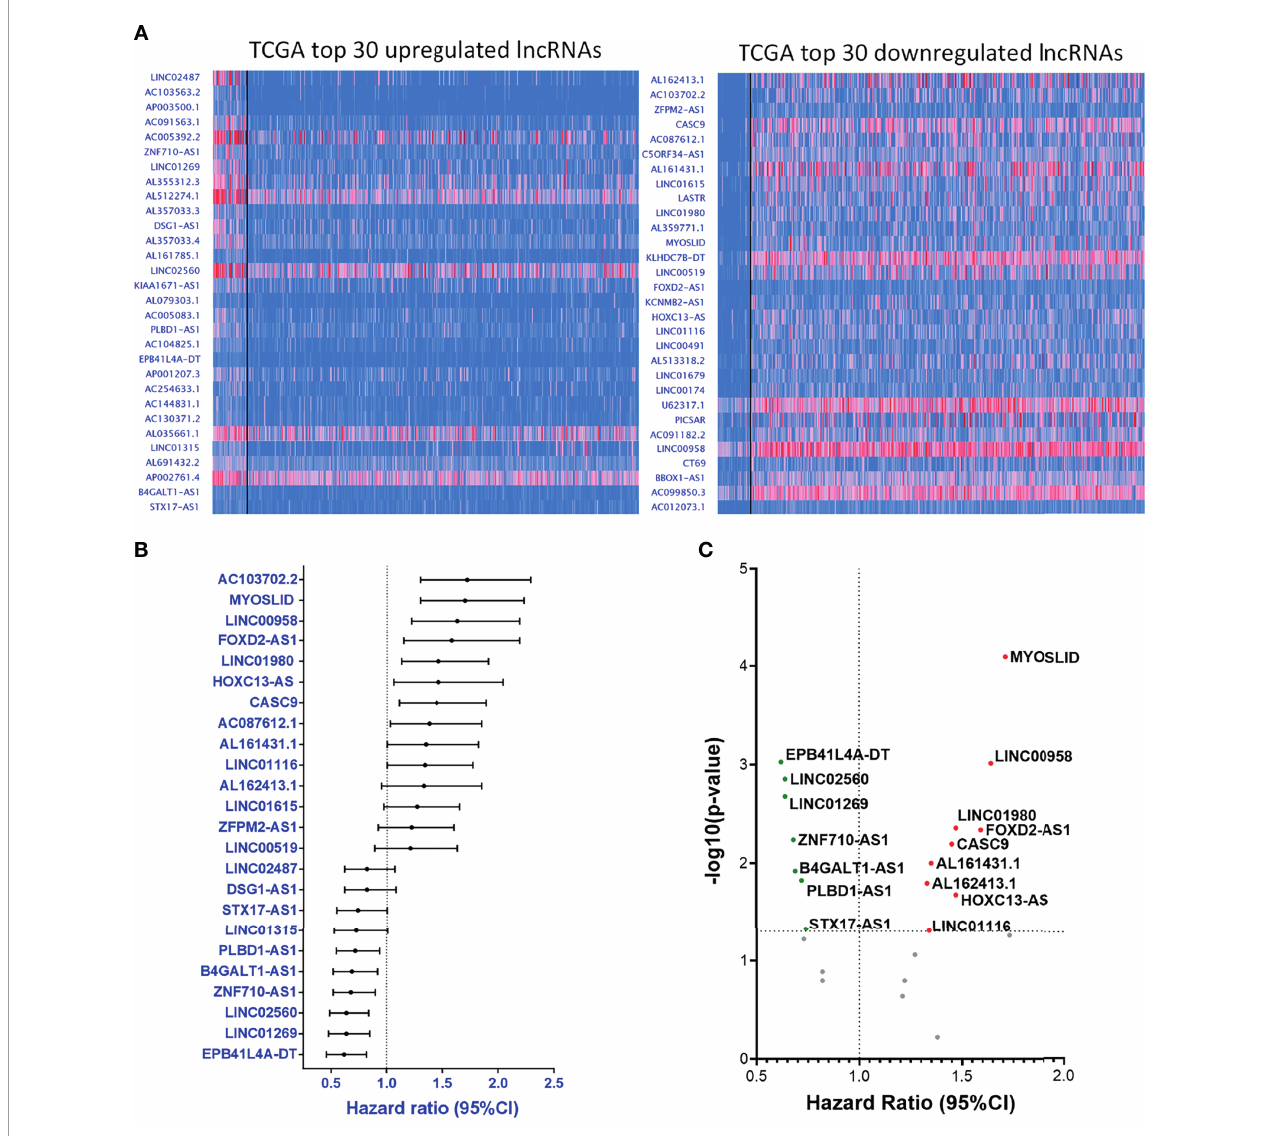
FIGURE 4 | Parallel prognostic signi fi cance analysis of clinical samples based on the top 60 dysregulated lncRNA expressions from TCGA-HNSC dataset by UALCAN. (A) RNA-seq data of the top 30 upregulated (left) and downregulated (right) lncRNAs were analyzed and depicted through the UALCAN resource. (B) HRs of 24 signi fi cantly dysregulated lncRNAs. A total of 34 lncRNAs were examined, post-exclusion of lncRNAs with incomplete prognostic information. (C) -(Log 10 -p- value) versus HR volcano plot of the 24 signi fi cantly dysregulated lncRNAs. A total of 16 lncRNAs were signi fi cantly correlated with cancer prognosis (p-value ≤